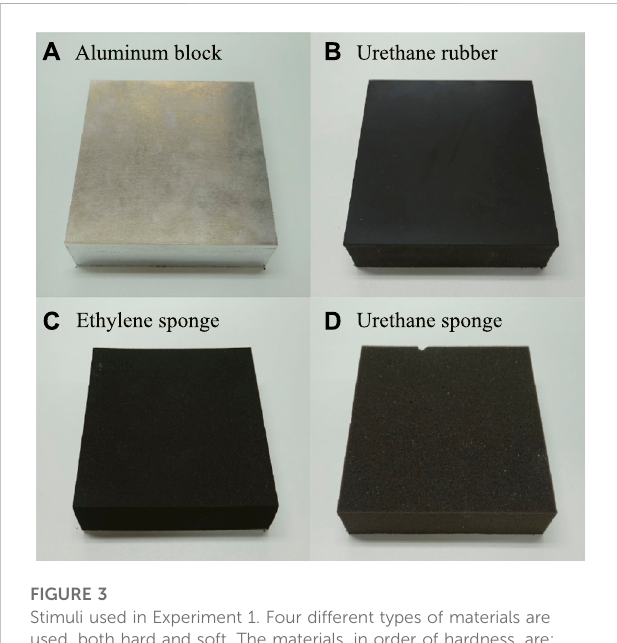
Stimuli used in Experiment 1. Four different types of materials are used, both hard and soft. The materials, in order of hardness, are: aluminum block, urethane rubber, ethylene sponge, and urethane sponge.